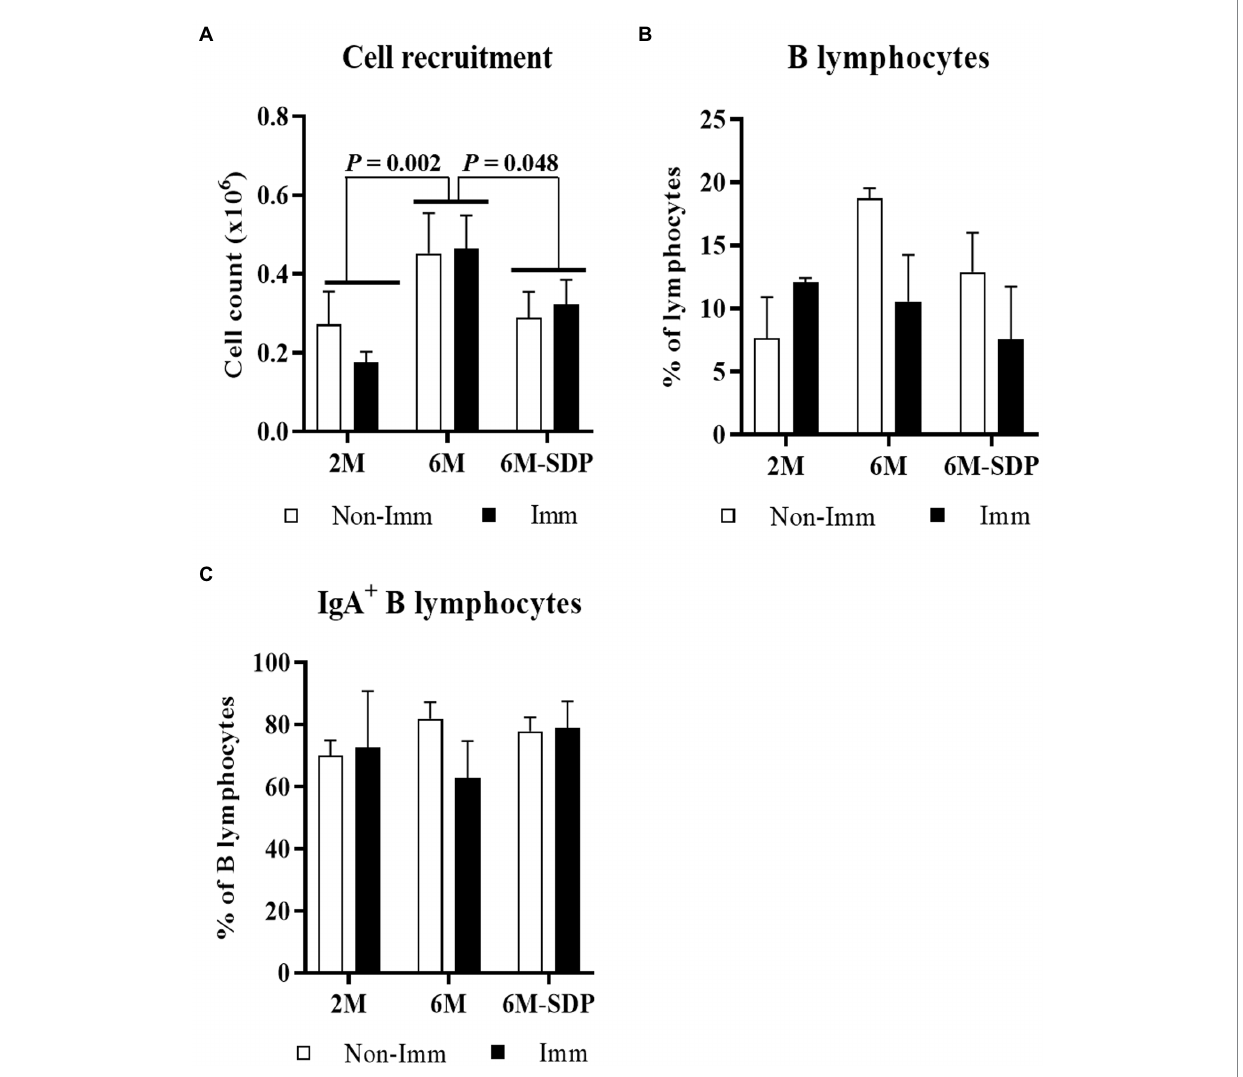
FIGURE 4 Cell count (A) , percentage of B lymphocytes (B) , and percentage of IgA + B lymphocytes (C) in bronchoalveolar lavage fluid (BALF). Open bars represent non-immunized mice ( Non-Imm ); solid bars represent immunized mice ( Imm ). Results are expressed as means ± SEMs ( n = 9–10 animals). Statistics: two-way ANOVA (age-feed and immunization factors; Fisher multiple comparison test). IgA, immunoglobulin A; SDP, spray-dried porcine